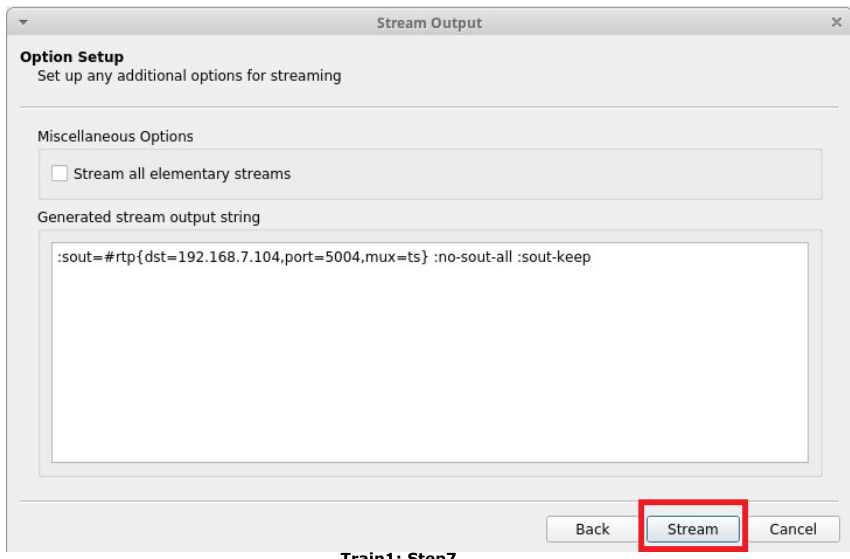
Figure 36. Train1: stream the